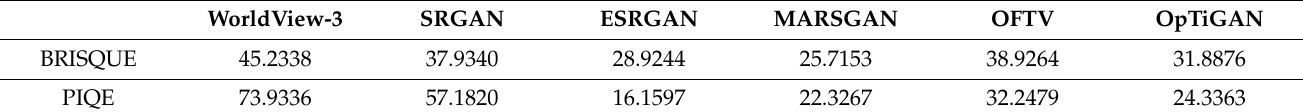
Table 2. BRISQUE and PIQE assessments of the WorldView-3 image and its SRR results at Baotou Geocal site.